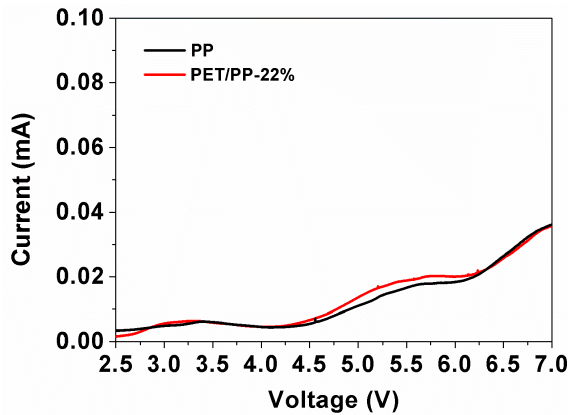
Figure 13. Liner sweep voltammetry of SS/PP/Li and SS/PET/PP-22%/Li cell.